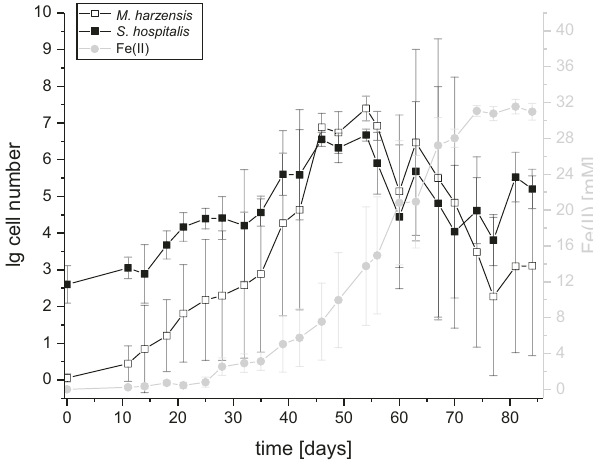
Fig. 1 Growth curve of a Ca. Micrarchaeum harzensis- Ca. Schef fl eriplasma hospitalis co-culture. Depicted are the mean cell numbers of Ca. Micrarchaeum harzensis (empty squares) and Ca. Schef fl eriplasma hospitalis (full squares) calculated via qPCR and the ferrous iron concentration (light grey circles) over time. Error bars show standard deviation of triplicates. Source data are provided as a Source Data fi